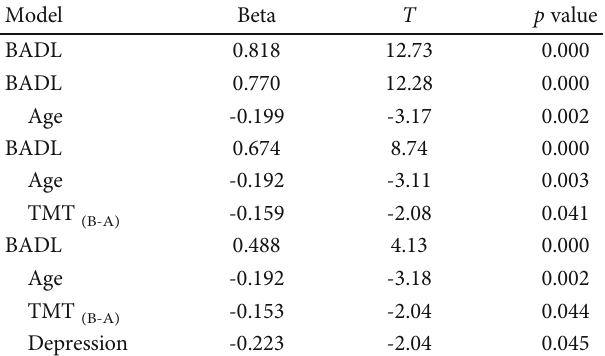
Table 5: Stepwise analysis of linear regression model for